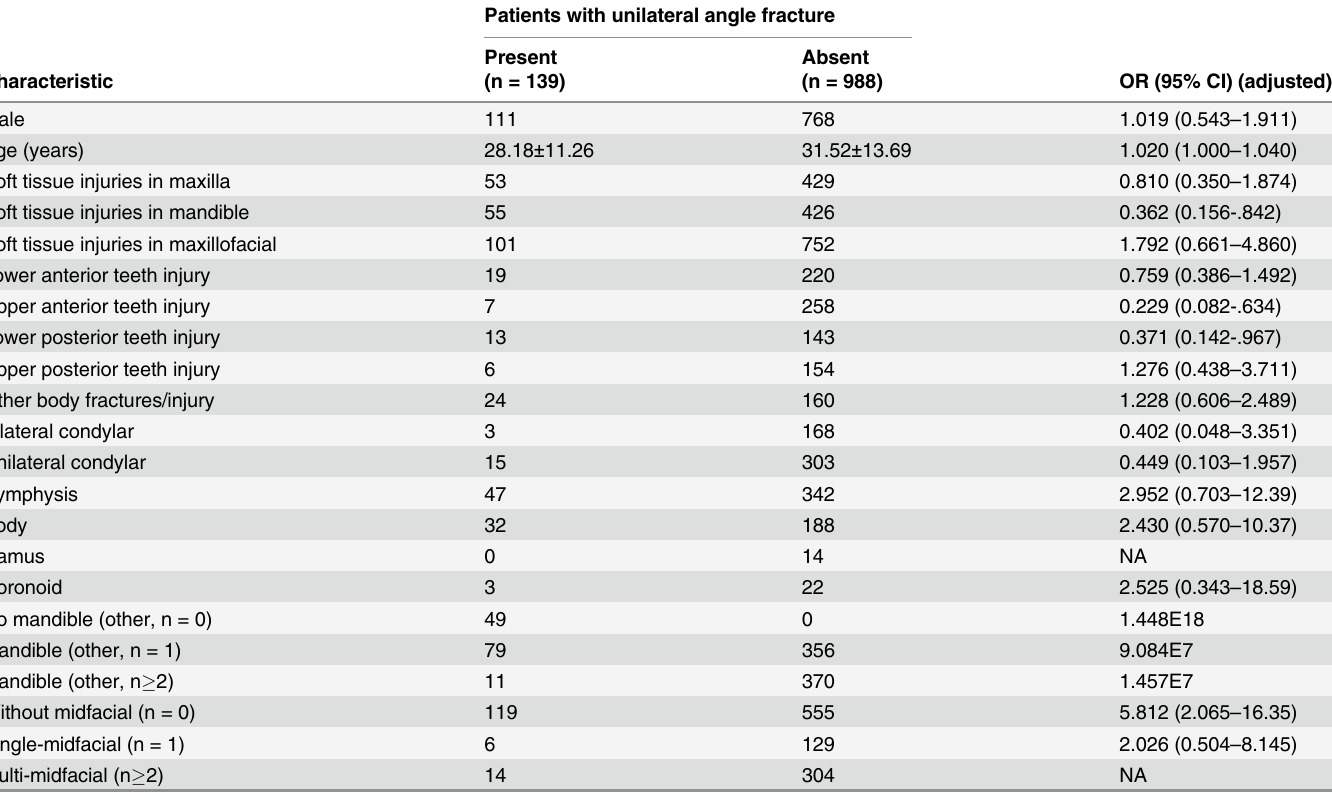
Table 4. Multivariate logistic regression analysis of patients with unilateral mandibular angle fractures. Patients with unilateral angle